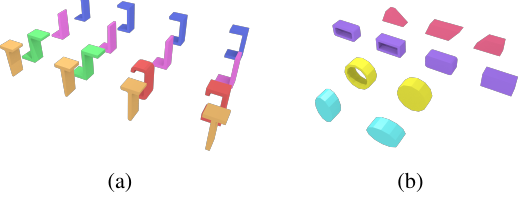
Figure 2. IFC defines various types of parametric curved pro- files such as (a) those based on the characters U, L, Z, C and T and (b) those based on trapezia, (rounded) rectangles, circles with/without holes and ellipses. Note the various types of tapered and curved parts of the profiles. These are most commonly used in extrusions such as those shown